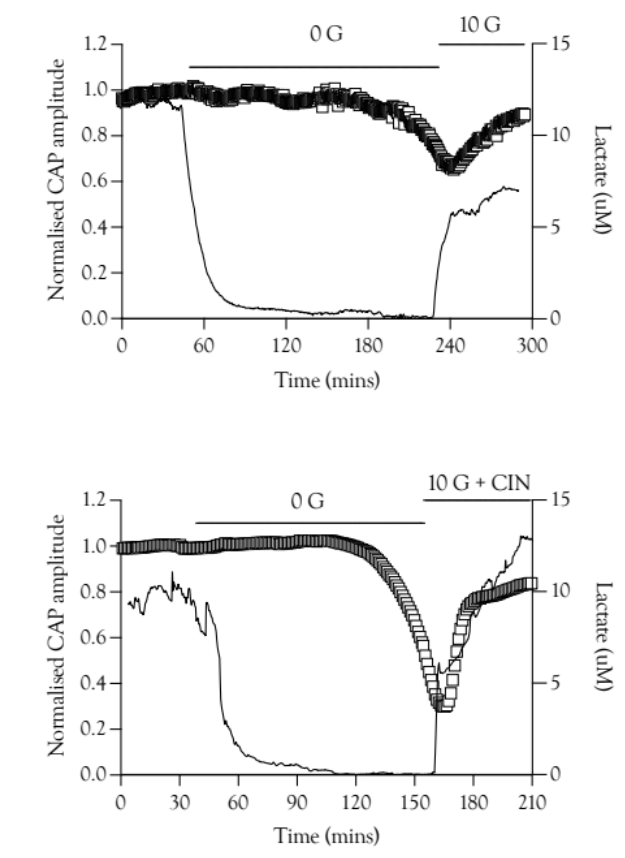
Figure 7. CAP recovery is preceded by elevations in extracellular lactate [lac] o . ( A ). Recovery of the A fibre CAP is delayed compared to recovery of [lac] o in 10 mM glucose. There is a temporal correlation between the onset of CAP recovery and the peak [lac] o level reached after introduction of 10 mM glucose, n = 3. ( B ). A similar effect was seen in recovery with 10 mM glucose and CIN, where the CAP recovers only after an initial rapid increase in [lac] o , n = 3.